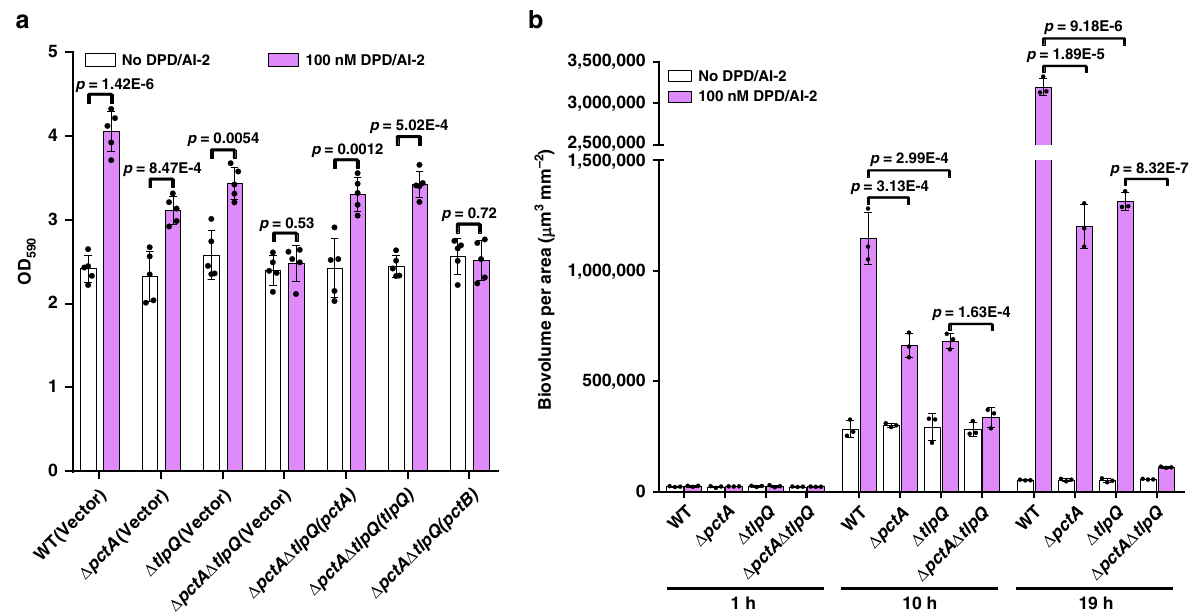
Fig. 3 AI-2 regulates P. aeruginosa bio fi lm formation via PctA and TlpQ. a Crystal violet quanti fi cation of bio fi lm formation by P. aeruginosa strains in the presence or absence of DPD/AI-2. 190 μ l aliquots of P. aeruginosa strains with an OD 600 of 0.05 in TSB medium were placed into the wells of a 96-well plate and then 10 μ l aliquots of DPD/AI-2 (2 μ M) or a buffer control were added to the wells. Bio fi lms were stained with crystal violet and quanti fi ed using optical density measurement after incubation at 37 °C for 48 h. Data are mean ± s.e.m. of fi ve independent experiments. b Quanti fi cation of bio fi lm formation by P. aeruginosa strains from confocal imaging. Confocal dishes were inoculated with 190 μ l of mCherry-labeled P. aeruginosa strains diluted to an OD 600 of 0.01 in TSB medium and 10 μ l of the DPD/AI-2 solution (2 μ M) or a buffer control, and bio fi lms formed were detected by confocal laser-scanning microscopy after incubation at 37 °C for 1, 10 and 19 h, respectively. Images were reconstructed using the Imaris 9.0 software package (Bitplane, AG) (Supplementary Fig. 6) and bio fi lm biovolumes were quanti fi ed using COMSTAT (www.comstat.dk). Biovolumes were calculated from three biological replicates and each biological replicate was derived from an average of fi ve confocal images. Similar results were obtained in three biological replicates and data are presented as mean ± s.e.m. a , b Statistical signi fi cance was evaluated using two-tailed unpaired Student ’ s t -test. P values < 0.05 were considered to indicate statistically signi fi cant differences. WT,